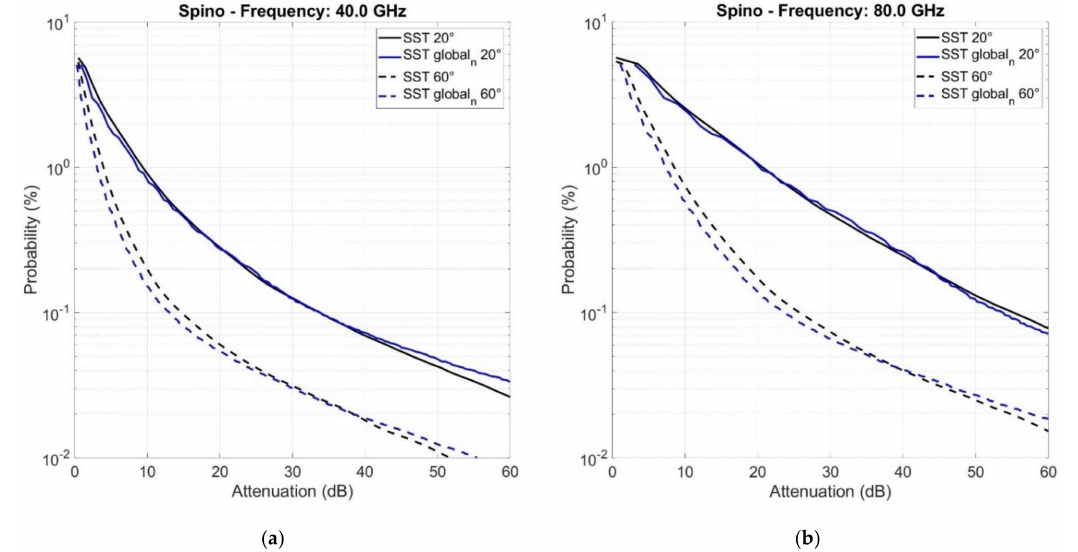
Figure 3. P SST ( A ) (black lines) and P SST , glo ( A ) (blue lines) at 40 GHz ( a ) and at 80 GHz ( b ) at Spino d’Adda, for θ = 20 ◦ (continuous lines) and θ = 60 ◦ (dashed lines).